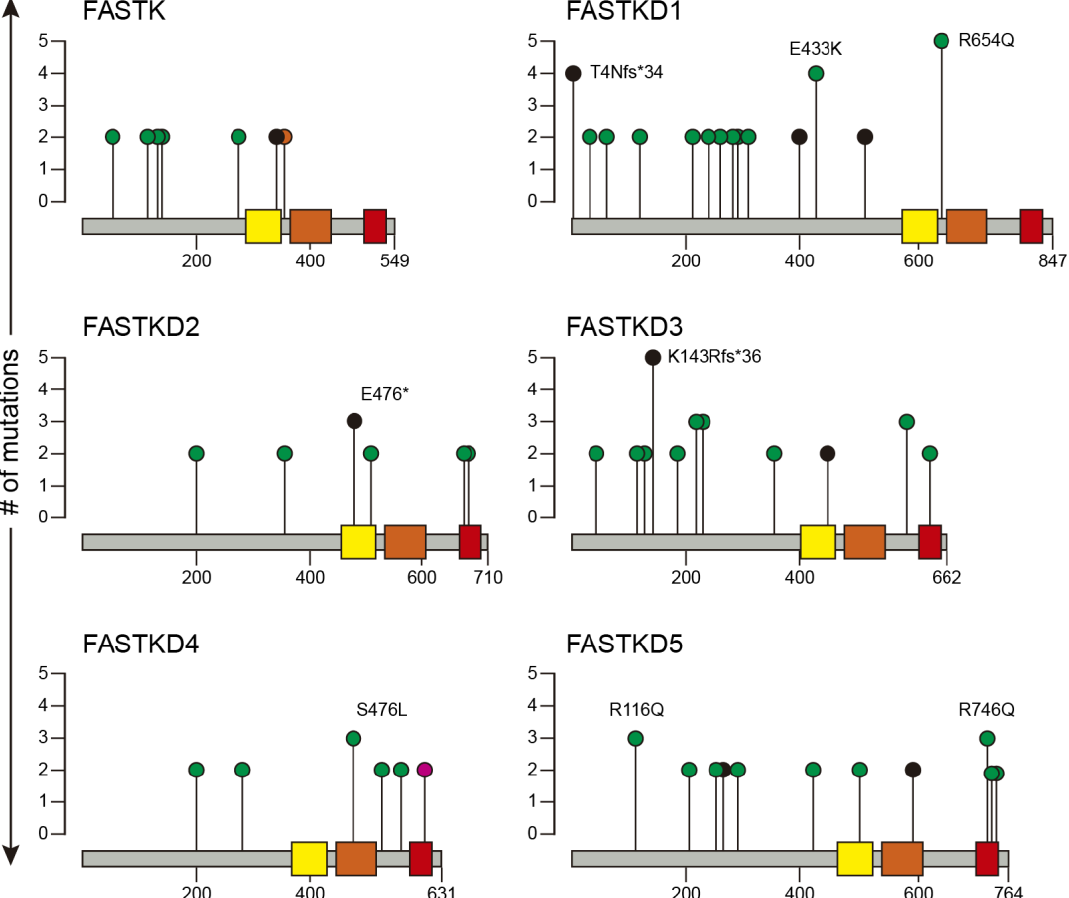
Figure 2. Lolliplots showing identified variants relative to a schematic representation of the protein (figure adapted from the lolliplots downloaded from cBioPortal). X -axis shows the amino acid position and y -axis the number of mutations. Positions which are recurrently mutated (total count ≥ 3) are labelled with text specifying the amino acid changes. Colors represent different types of mutations: green-missense, black-truncating, orange-splicing and magenta-silent. FAST_1 FAST kinase-like domain 1(yellow), FAST_2 FAST kinase-like domain 2 (orange), RAP RNA binding domain abundant in apicomplexans (red). A complete description of the mutations can be found in Table S2.